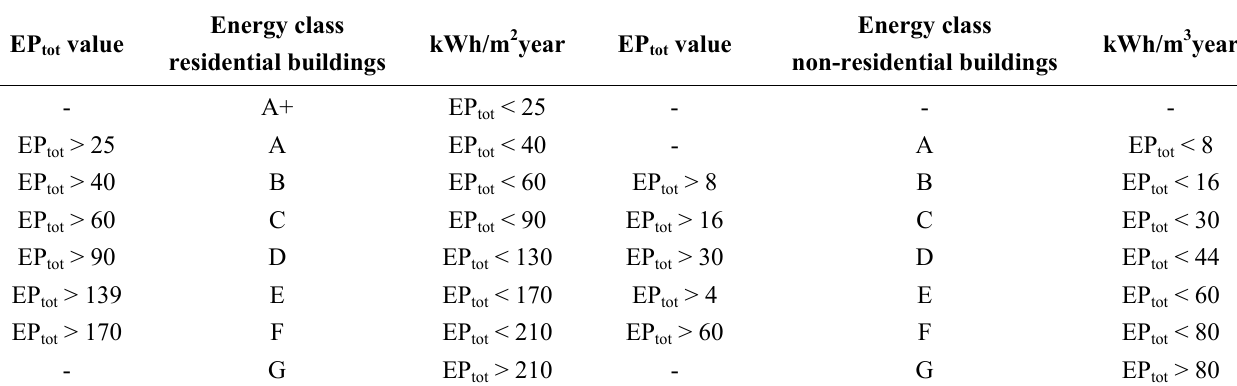
Table 1. Emilia-Romagna Region: Energy class performance—DAL 156/2008 Annex